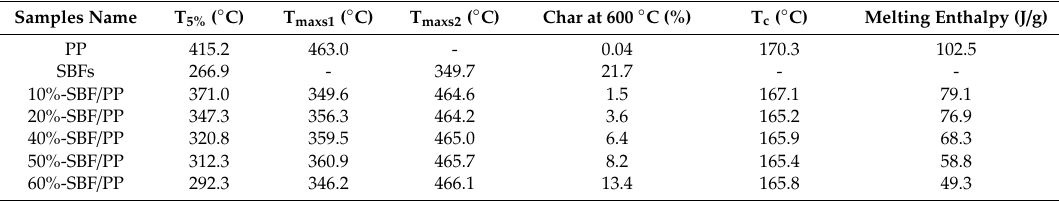
Table 2. Thermal properties of PP, SBFs, and the